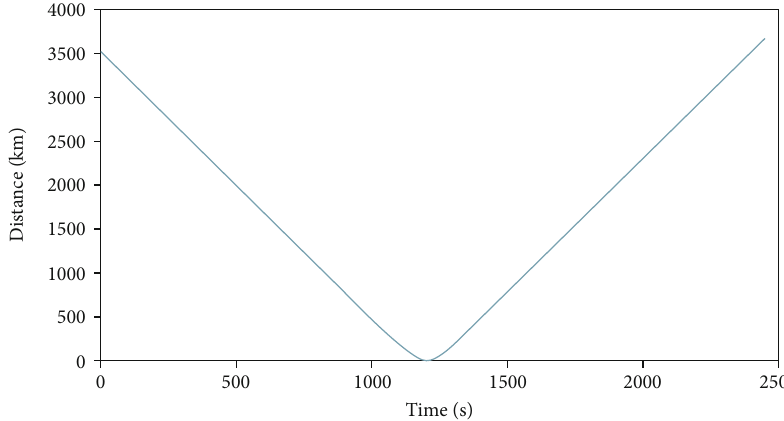
Figure 9: The variation of distance between active spacecraft and unreachable